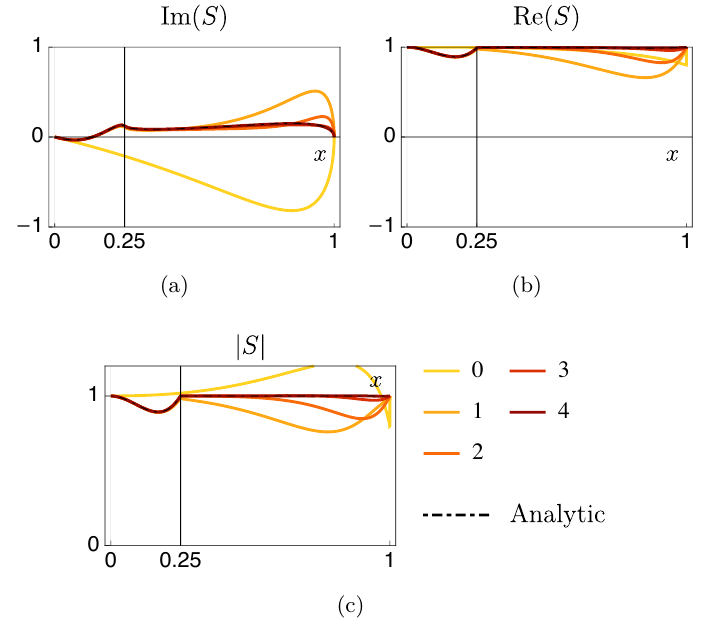
Figure 4 . Results of the iterations for one bound state and a fixed constant at infinity. Obtained for c = − 3 , m 2 = 2 . 8 , H = 40 . The result of the first four iterations only. The analytic solution is ∞ p given by (2.10) with S = S pole with m 2 = 3 . 225 . . . , as per eq. (2.12). Linear interpolant, S zero elastic z CDD CDD grid given in eq.